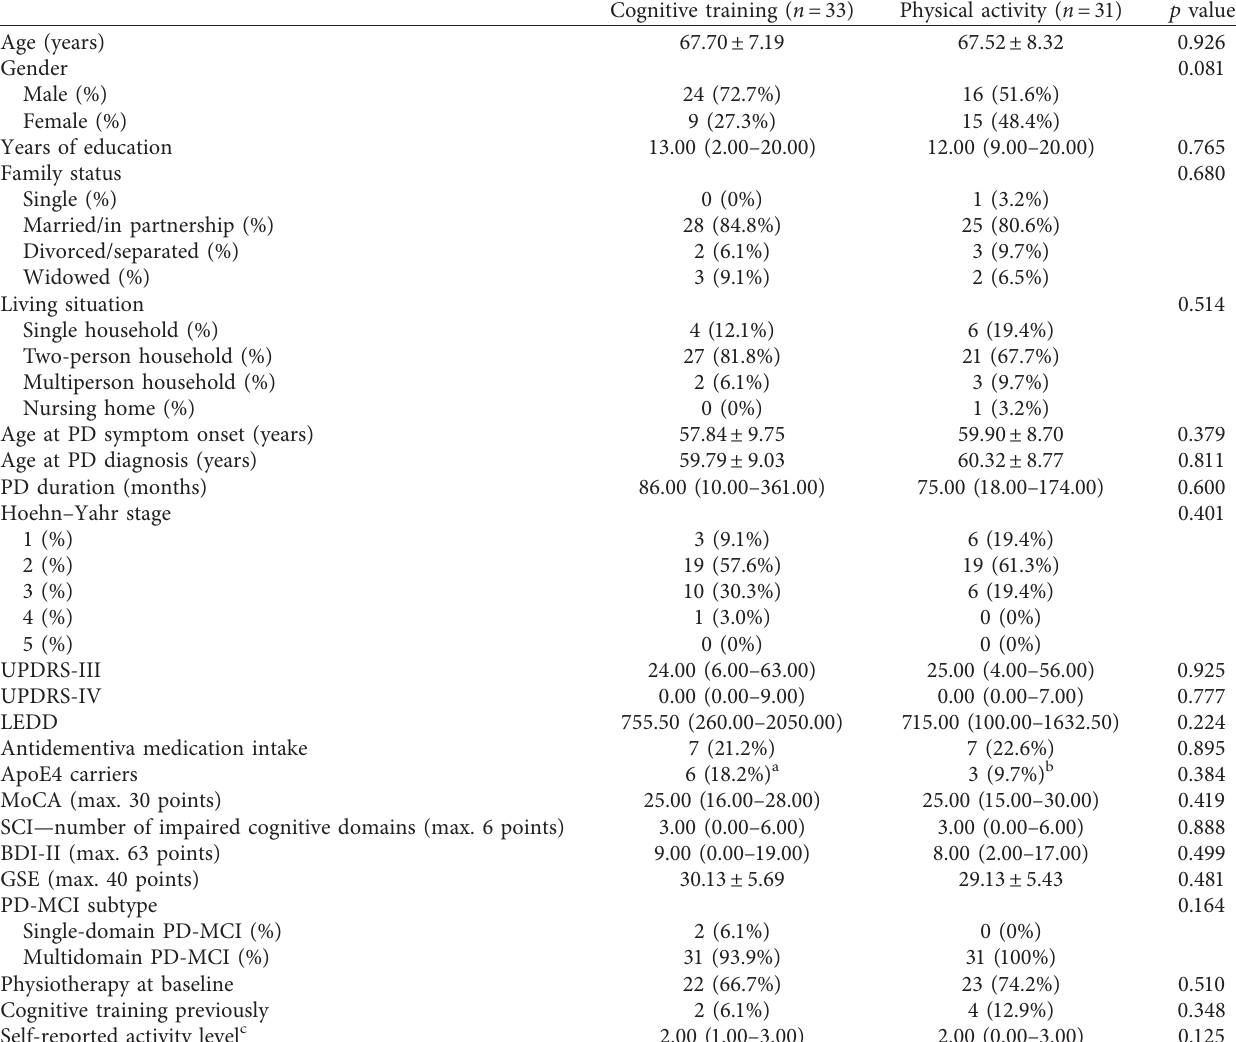
Table 3: Baseline demographic, clinical, neuropsychological, and genetic characteristics of the PD-MCI study sample. Cognitive training ( n �